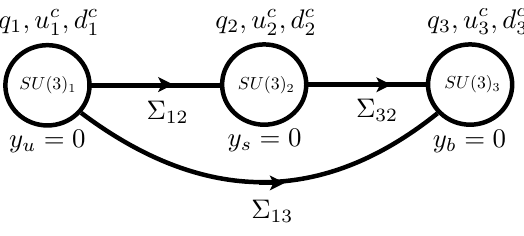
Figure 3 . The model is a 3-site SU(3) 1 (cid:2) SU(3) 2 (cid:2) SU(3) 3 theory, with one generation charged under each SU(3) factor. The link (cid:12)eld (cid:6) vevs break the gauge group down to the diagonal SU(3) of the standard model. One quark in each generation obtains its mass from non-perturbative e(cid:11)ects, making the (cid:22) (cid:18) angle in each individual gauge factor